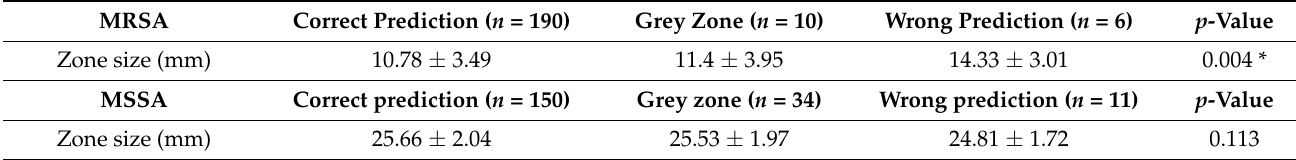
Table 2. Zone size of cefoxitin for MRSA and MSSA. MRSA with wrong AST prediction (predicted as MSSA) had a significantly larger zone diameter than correct-prediction and grey-zone groups, indicating that the phenotype of MRSA with wrong AST prediction is more like MSSA.